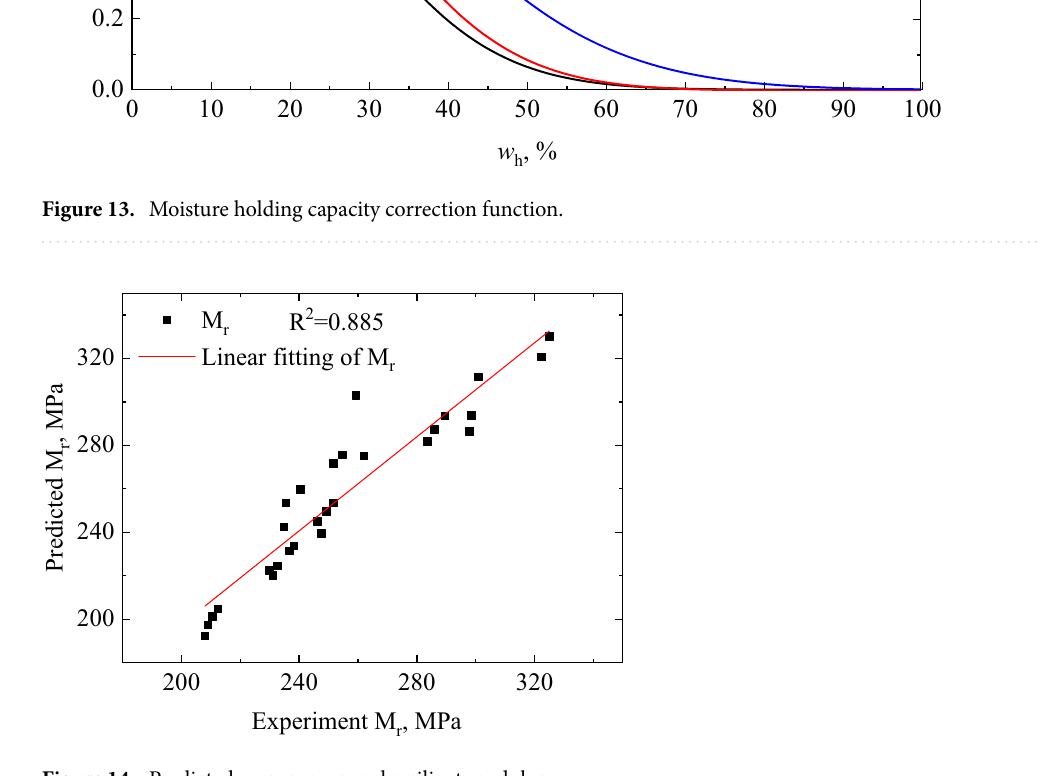
Figure 14. Predicted versus measured resilient modulus.